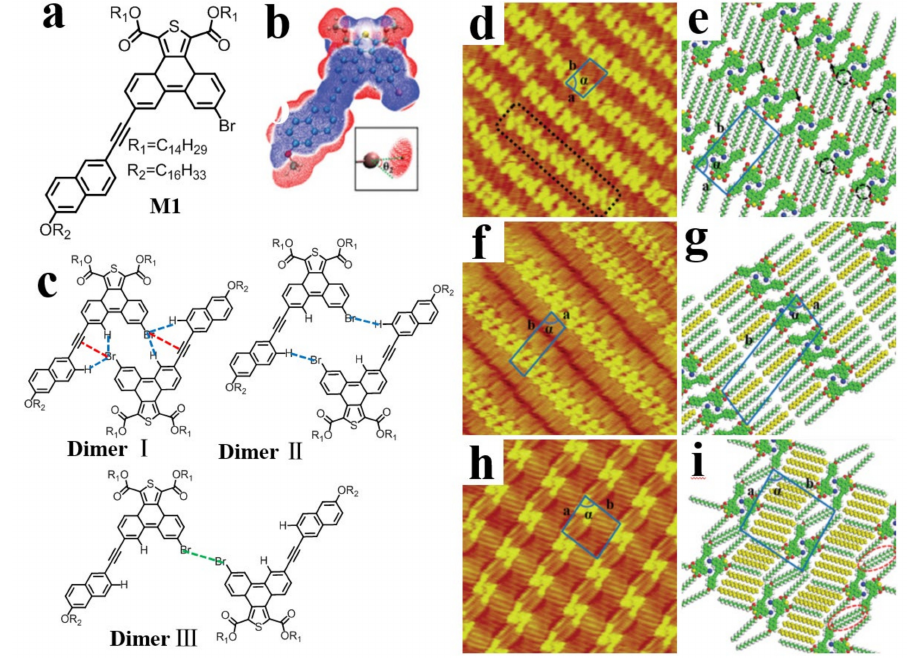
Figure 17. ( a ) Chemical structure of M1. ( b ) Calculated 3D ESP map of the M1 conjugated core. ( c ) Possible self-assembly dimers of M1 containing Br ··· π XB (dimer I), C − H ··· Br HBs (dimer II), and type-I Br ··· Br interactions (dimer III) depicted by red, blue, and green dotted lines, respectively. ( d ) A high-resolution STM image of the linear structure consisted of dimer I at the n- hexadecane / HOPG interface. Some dimer II structures are excluded by the black dotted rectangle. ( f , h ) High-resolution STM images showing the “tail-to-tail” and discrete structures, respectively. ( e – i ) Proposed structural models of ( d , f , h ). Image size: 20 × 20 nm 2 . Reproduced from [92] with permission from the Royal Society of